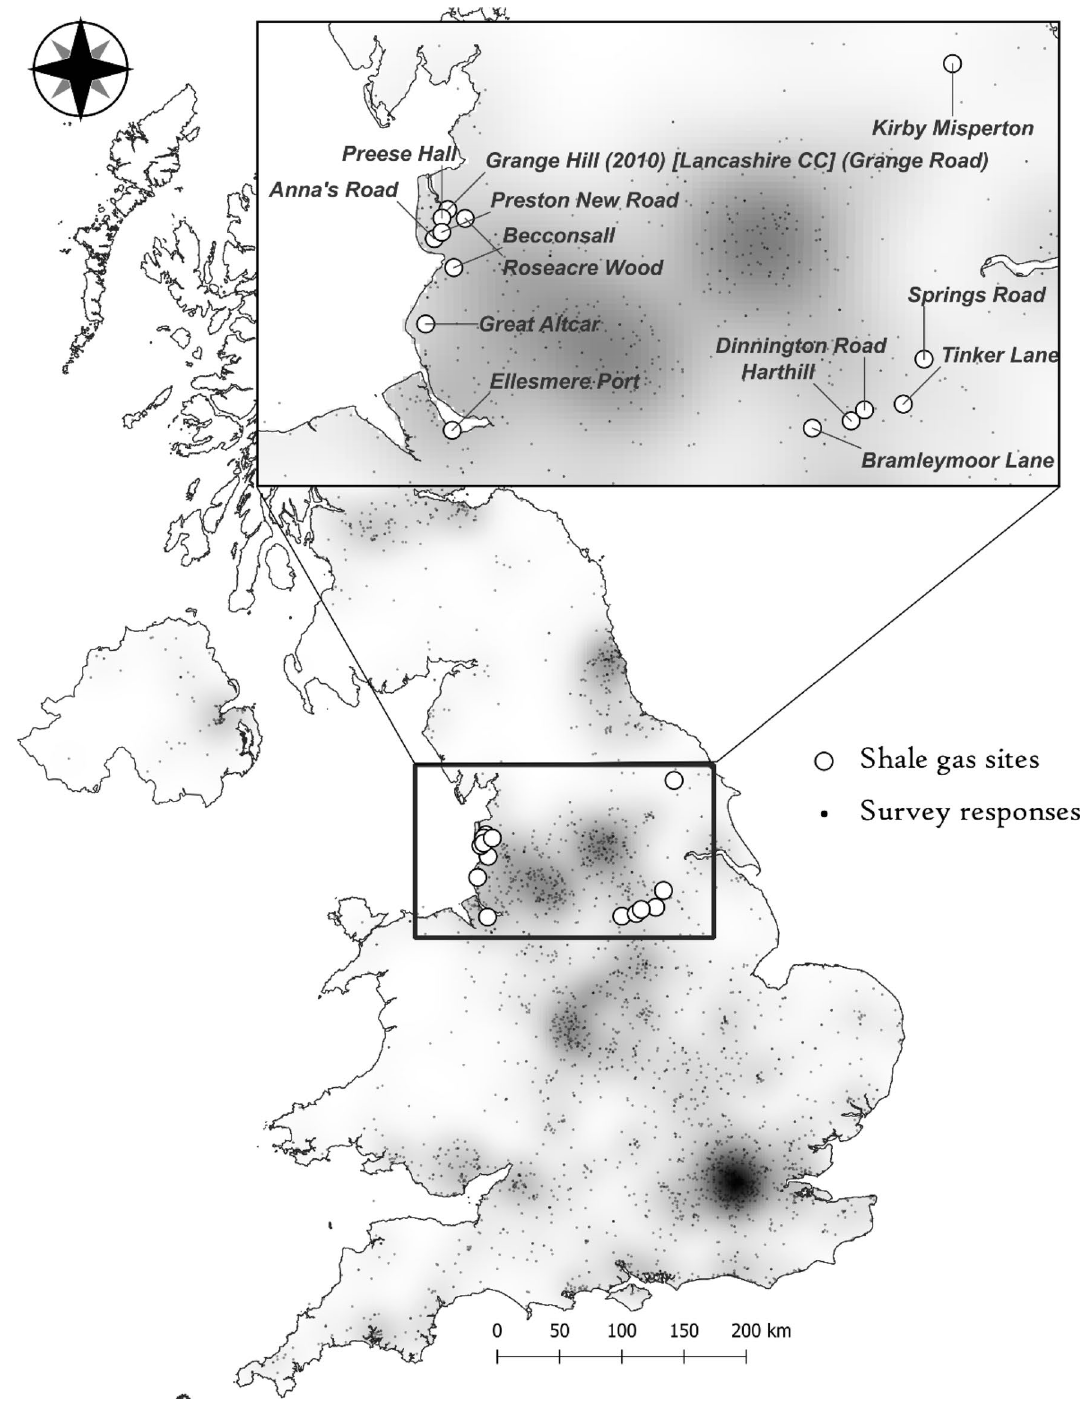
Figure 3. Spatial distribution of survey respondents plotted alongside sites that have been associated with shale